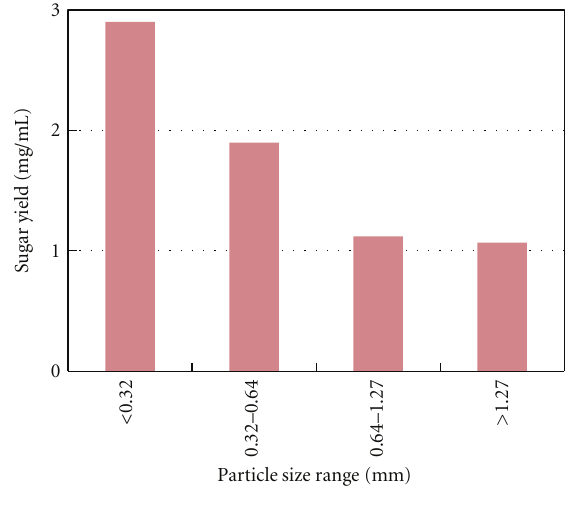
Figure 16: E ff ects of particle size on sugar yield reported by Zhu et al. [26].